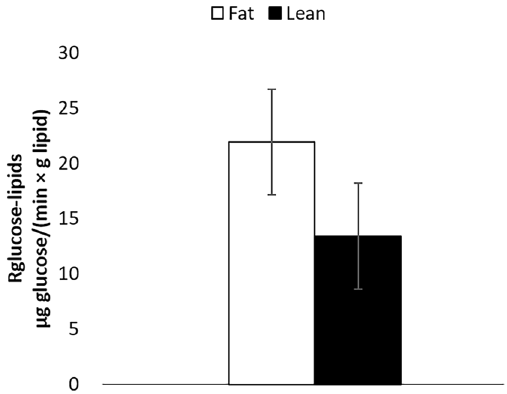
Figure 4. Estimations of the rate of glucose incorporation into lipids (R glucose-lipids ) of fat and lean pigs at 4 h after a bolus injection of [U- 13 C]glucose (trial 2). Error bars represent SE (n = 14).